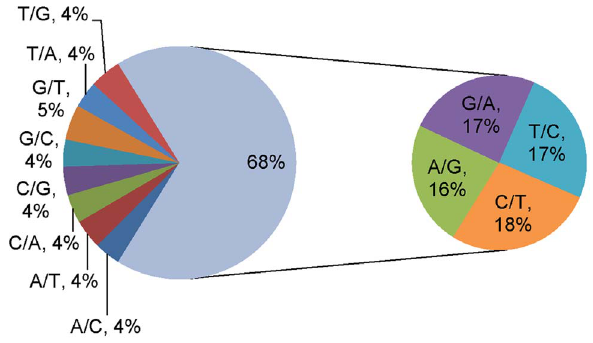
Figure 4. Example of a transcript showing allelic bias in Xieyou9308 at heading stage. Number of reads detected for a given parental allele at each SNP position is plotted.